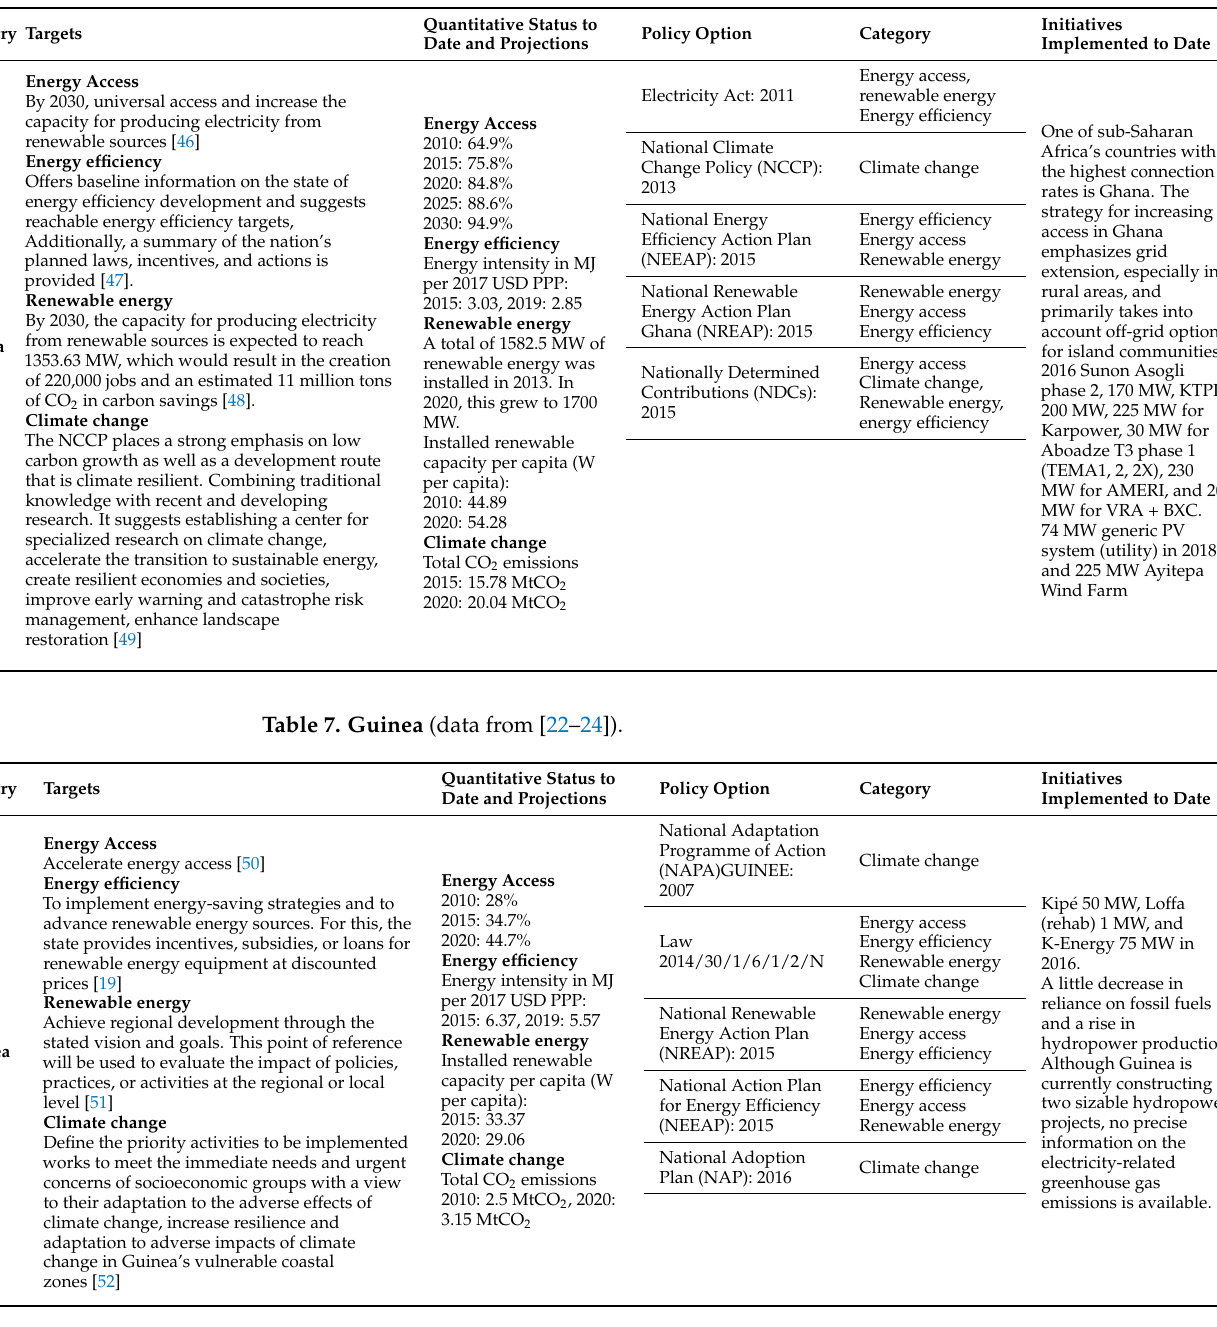
Table 6. Ghana (data from [22–24]).